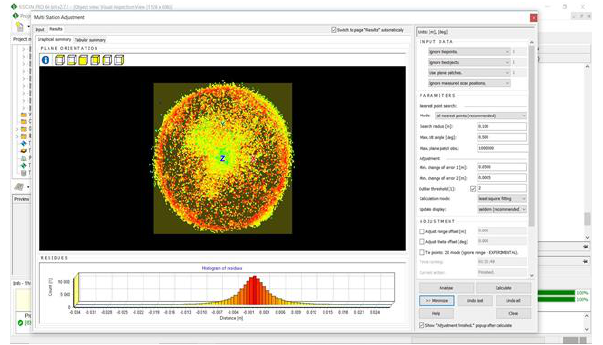
Figure 3. Detailed scan on flat circular